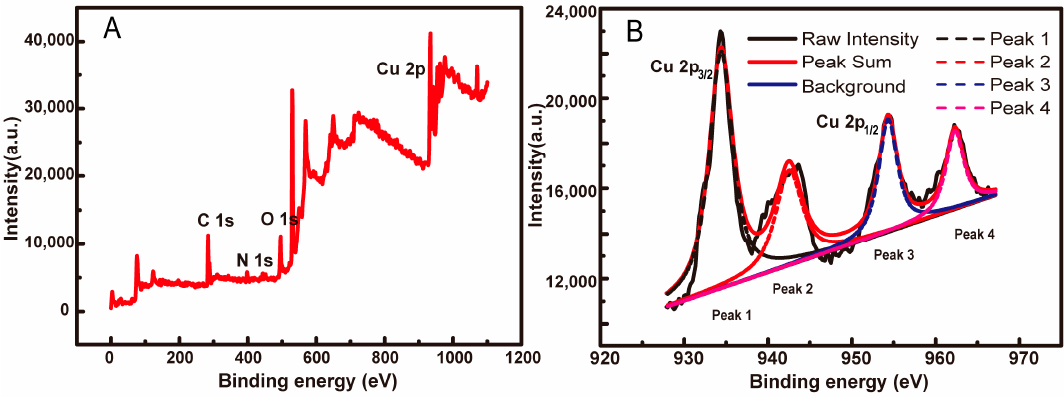
Figure 3. ( A ) XPS survey spectrum and ( B ) deconvoluted Cu 2p spectra for CuO/PCL@PPy/ITO.